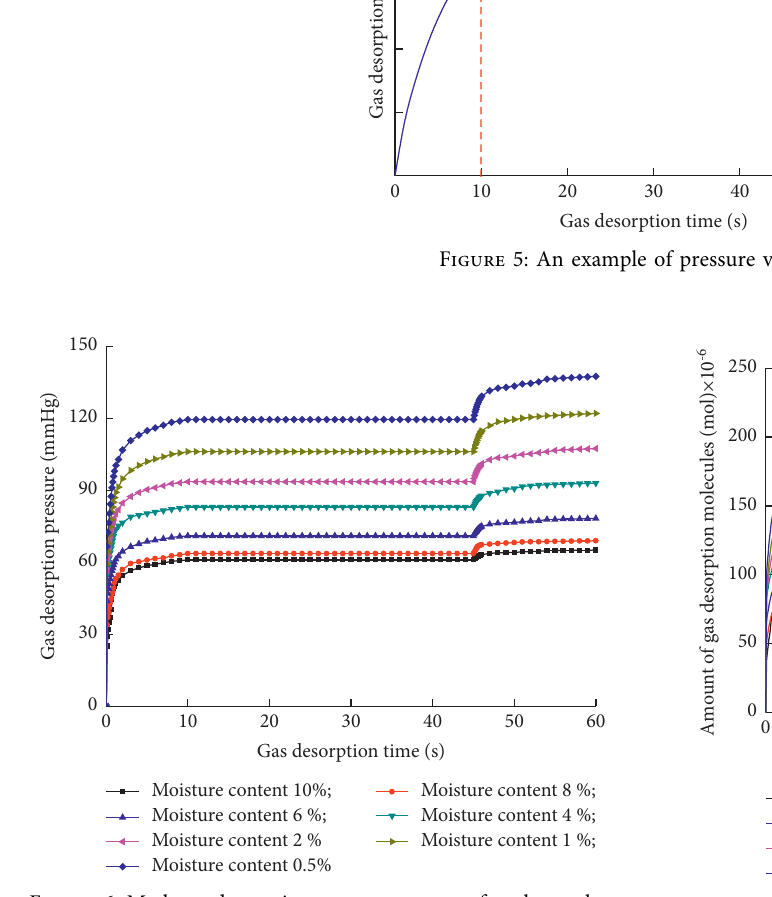
7: Te relationship between the total amount of methane